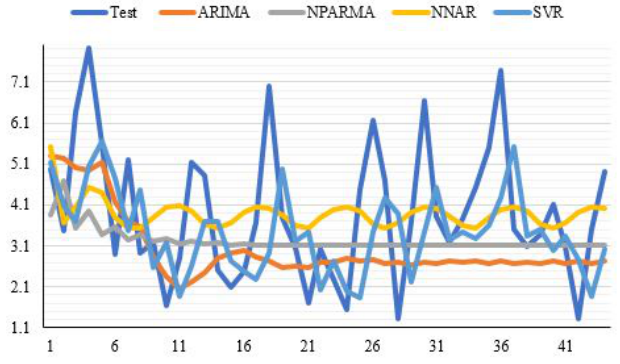
Figure 18. Forecasting performance of